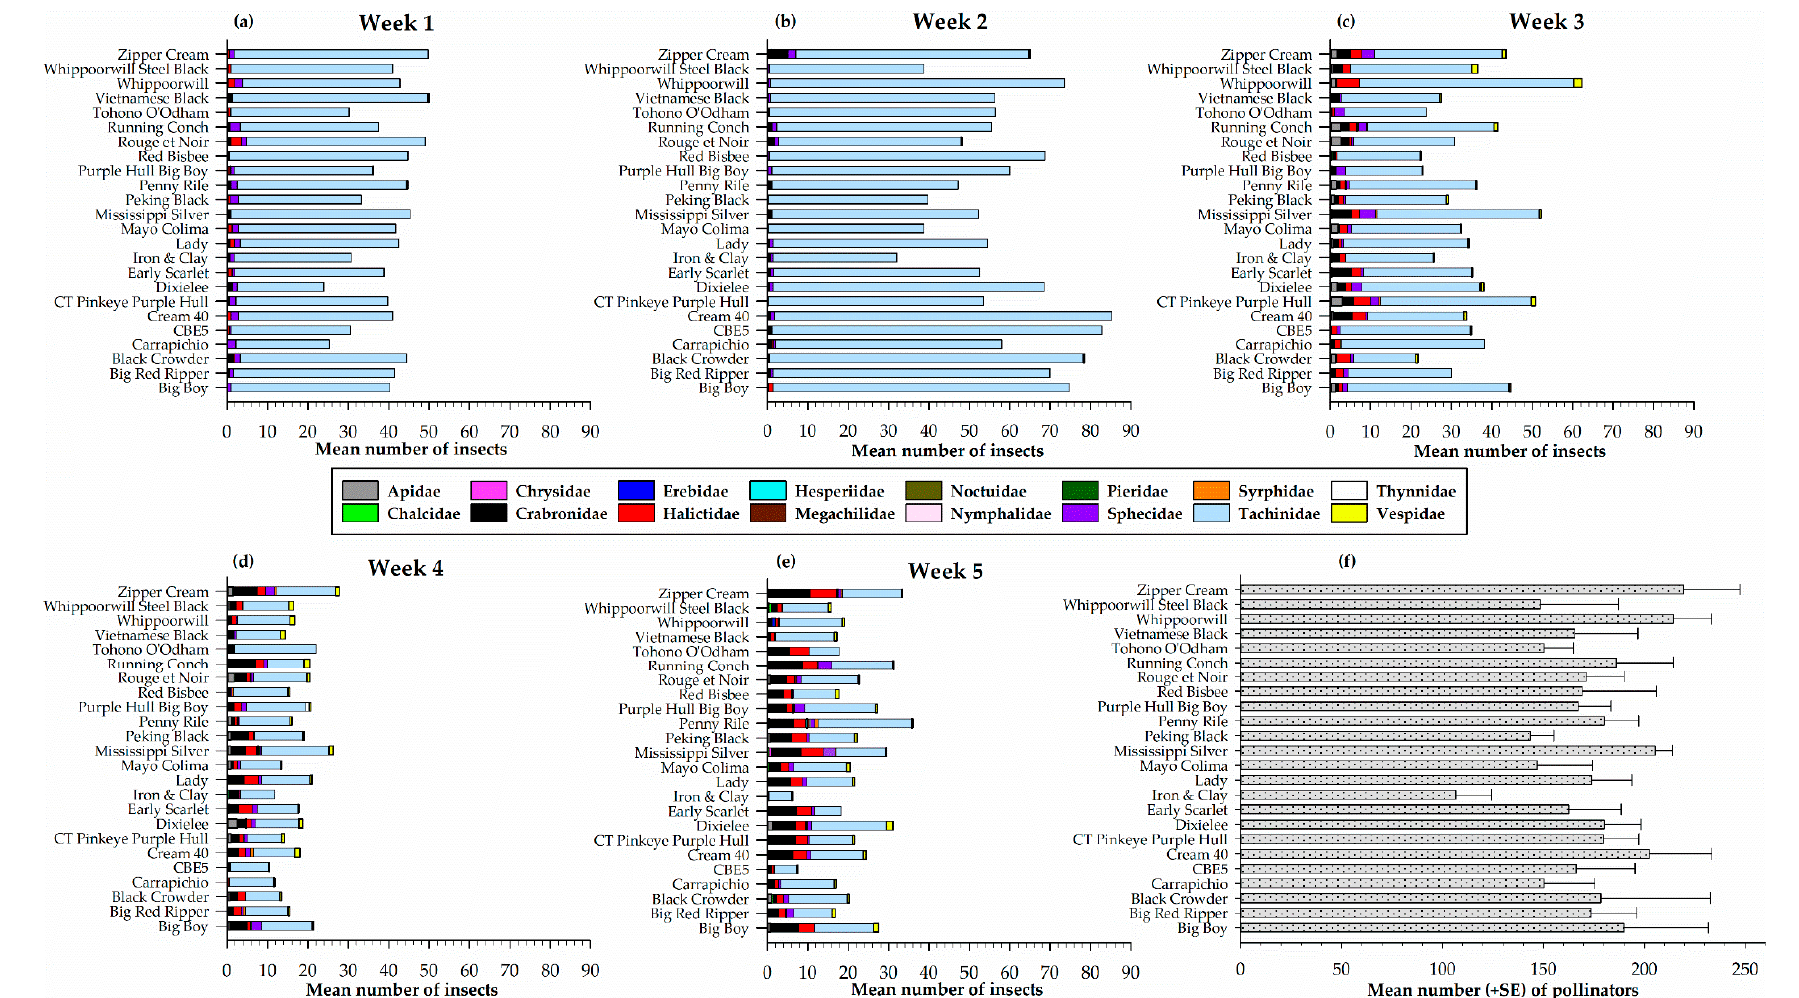
Figure 3. Weekly distribution of pollinator families ( a – e ) and total number of pollinators ( f ) on different cowpea varieties in sticky traps.